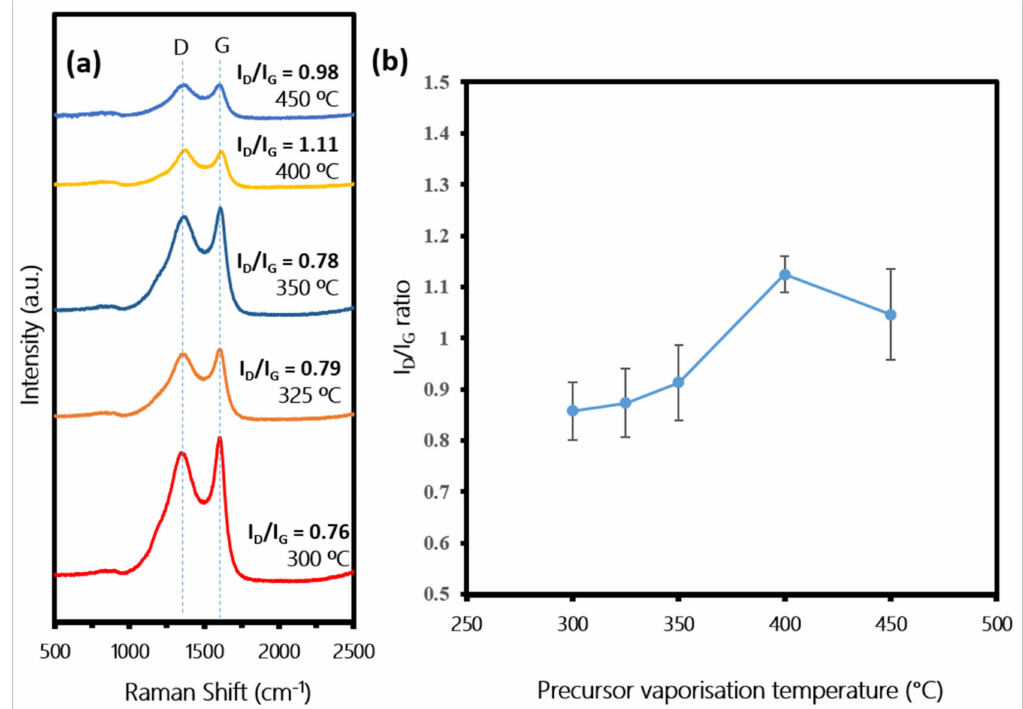
Figure 8. ( a ) Raman spectra of samples synthesized at various precursor vaporization temperatures of 300, 325, 350, 400 and 450 ◦ C. ( b ) Corresponding average I D /I G ratios,